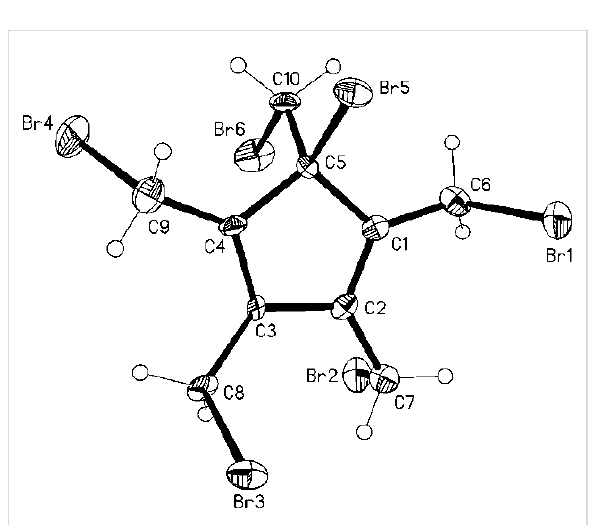
Figure 4: Structure of 32 in the crystal; ellipsoids represent 50% prob- ability